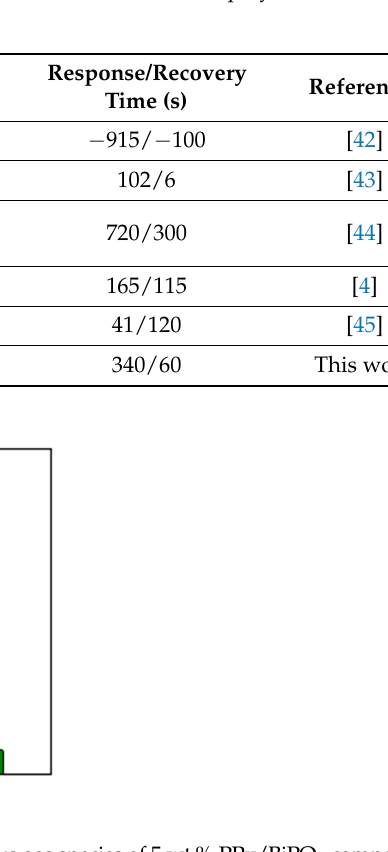
Figure 8. Selectivity towards relative humidity and various gas species of 5 wt.% PPy/BiPO 4 composites.